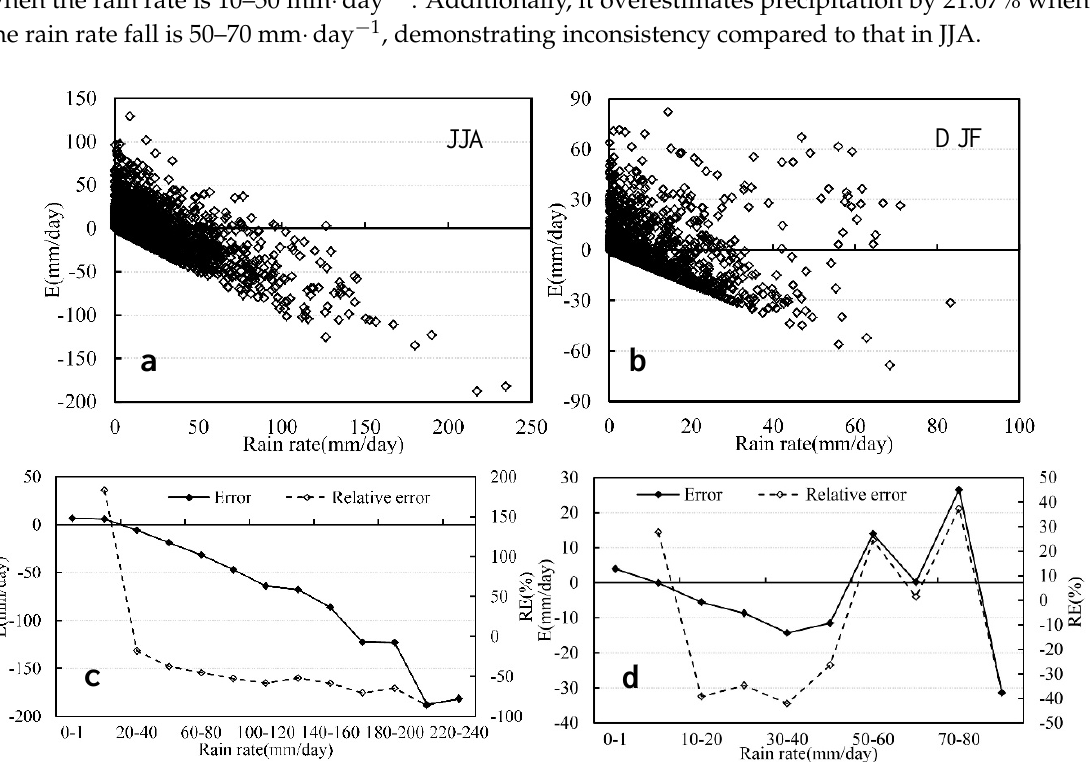
Figure 6. The relations between precipitation difference and rain rate at daily scale for TRMM 3B42, with ( a , c ) for June, July and August (JJA); ( b , d ) for December, January and February (DJF). (The interval for 0–20 mm ∙ day − 1 is subdivided into 0–1 mm ∙ day − 1 and 1–20 mm ∙ day − 1 for great value of relative error (RE) under 0–1 mm ∙ day − 1 ).